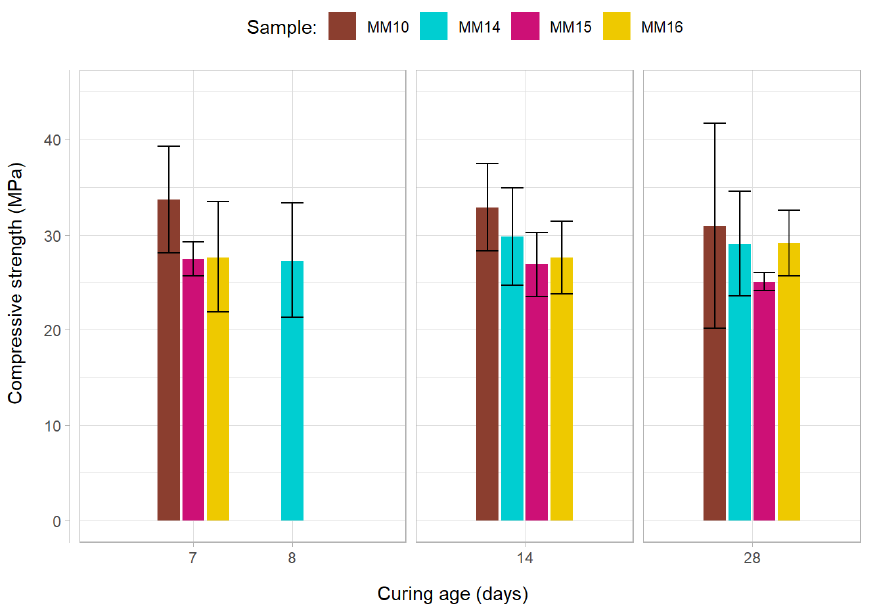
Figure 10. Compressive strength results for the waste glass optimization stage. ( a ) First and ( b ) second approach. Table 10. The p -values of the F-tests performed with the values of the compressive strength for different curing